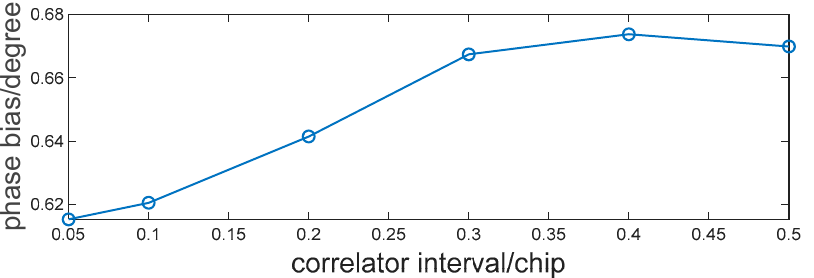
Figure 12. Carrier phase bias estimation between B2ad and B2ap of BDS3 prn 21 satellite.